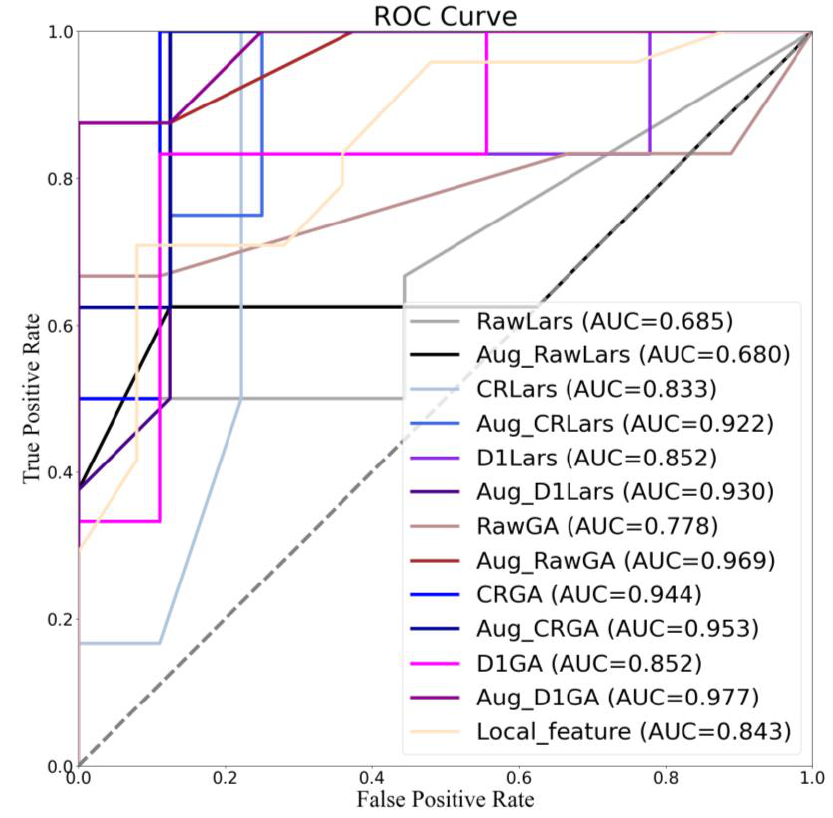
Figure 12. ROC curves.